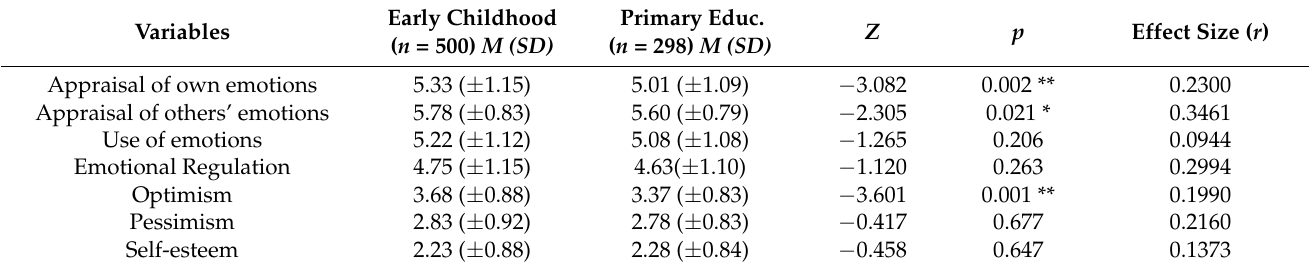
Table 5. Rank differences according to gender (U of Mann-Whitney Test).